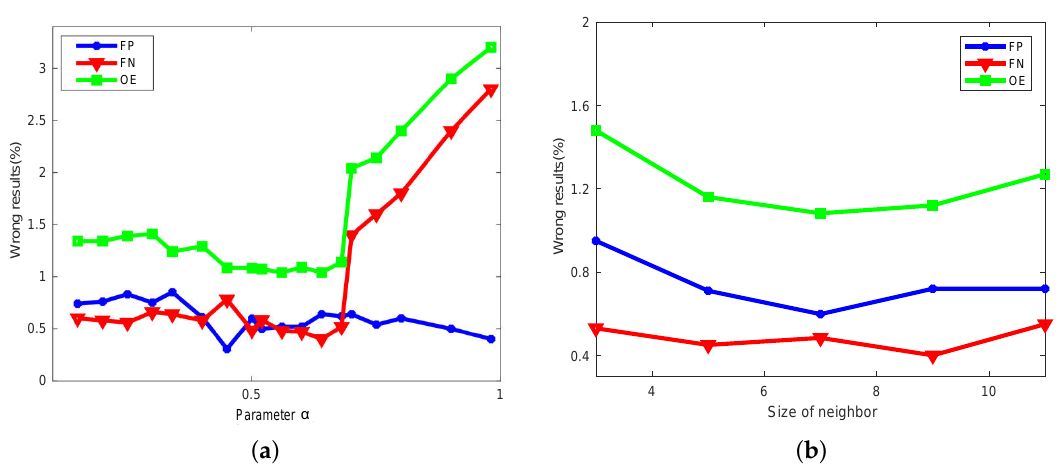
Figure 9. ( a ) Relationship between the size of the neighbor and FP , FN , and OE on the farmland dataset. ( b ) Relationship between the parameter α and the criteria on the farmland dataset.